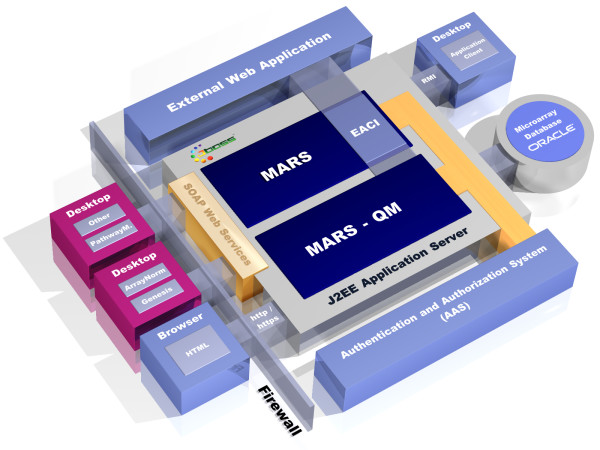
MARS system interactions. MARS and MARS-QM are deployed in a J2EE compliant application server. Interaction is possible either with a standard Web browser or an application supporting the SOAP or RMI protocol. The External Application Connector Interface (EACI) facilitates to connect to data from additional Web applications. SOAP and http/https enable MARS access also through firewalls.